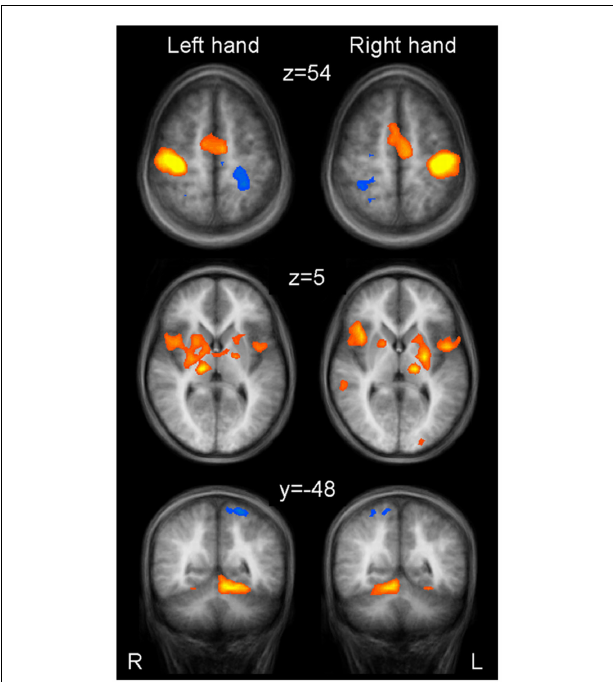
FIGURE 1 | Group activations for left hand finger tapping (left column) and right hand finger tapping (right column) versus motor rest, overlaid onto group-averaged anatomical images ( n = 24) in Talairach space . Significant signal changes ( p < 0.001; corrected for multiple comparisons) are coded in yellow/orange (positive) and green/blue (negative). L, left; R, right. The Talairach coordinate in millimeter is